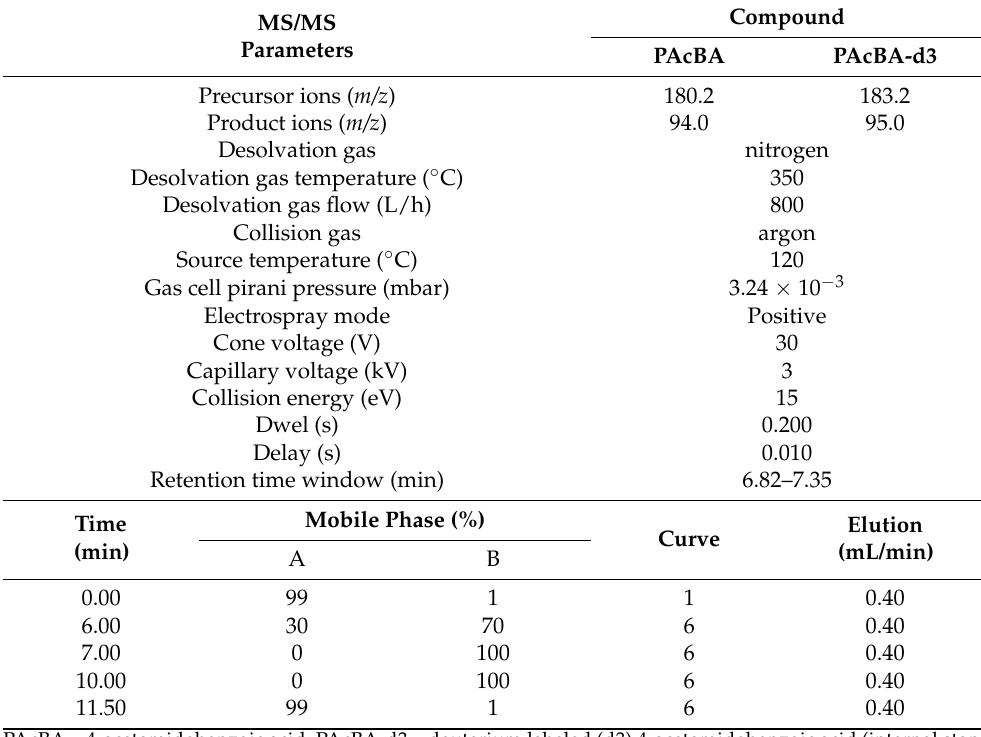
Table 1. Selected liquid chromatography and mass spectrometry